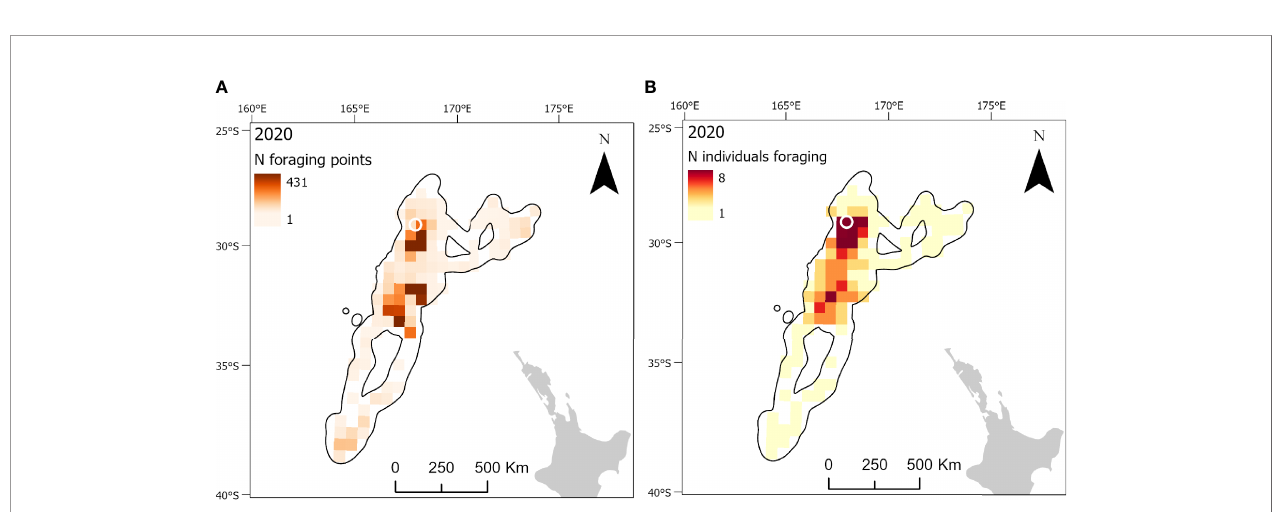
FIGURE 6 | At-sea distribution and locations of foraging behavior in chick-provisioning Kermadec petrels ( Pterodroma neglecta ). Grid cells (50 x 50 km) represent the number of foraging locations in each cell in 2020 ( A ; n = 9 individuals) and the number of individuals foraging in each grid cell in 2020 (B) . The location of the breeding colony is represented by a white circle. Black polygons around the foraging areas represent the home range (99% utilization distribution).